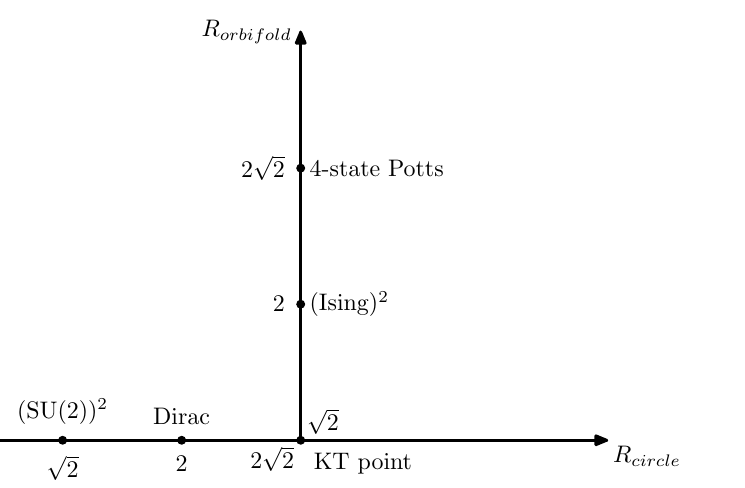
Figure 1 . Classi(cid:12)cation of conformal (cid:12)eld theories at central charge c =